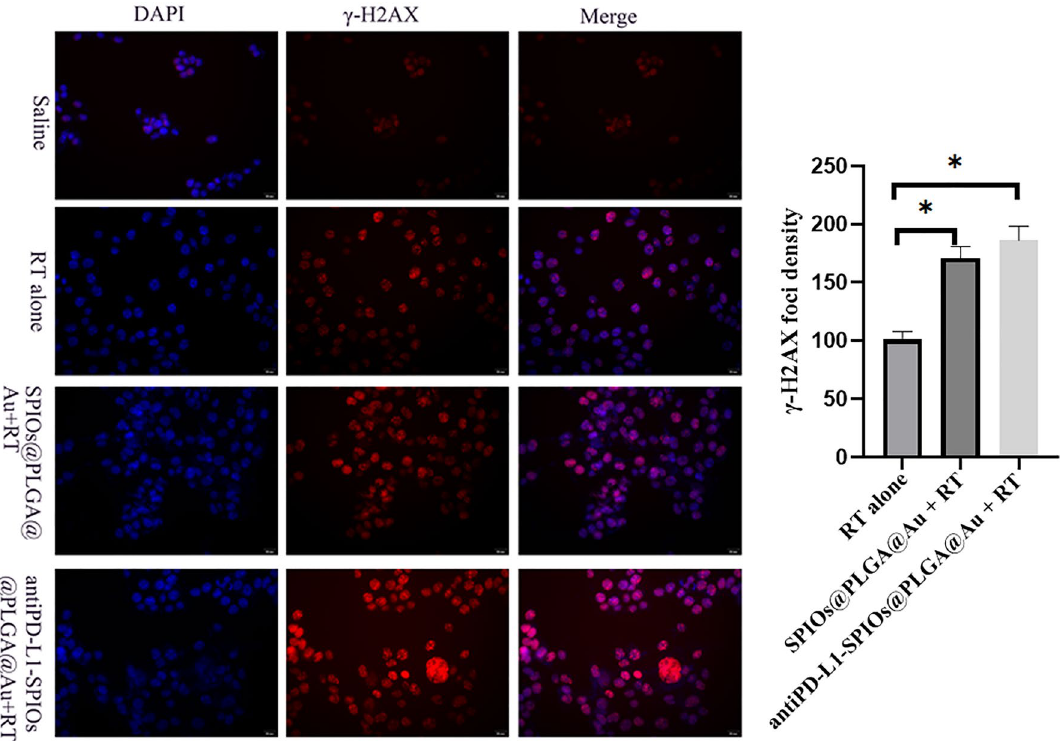
Figure 4. Focal fluorescence and quantitative analysis of γ-H2AX in different groups (* P <